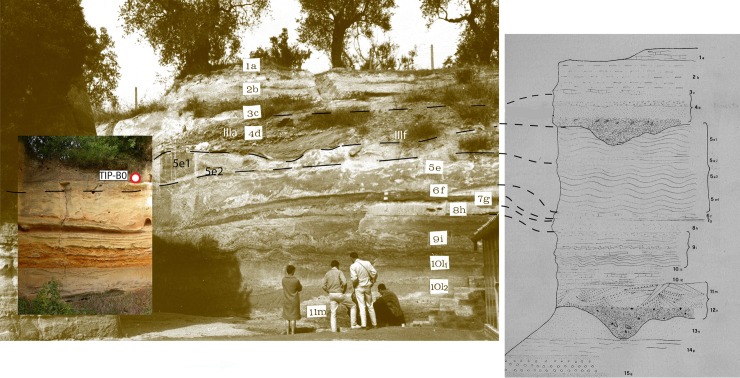
Stratigraphy of the main Torre in Pietra section.Center: the main section of excavations carried out between 1955 and 1964; (left) upper part of the Aurelia Formation with position of dating sample TiP-B0; (right) correlation with layers as drawn by [1]. The center and right panels of the figure are reprinted from [1] with permission by the Italian Institute of Human Paleontology (S4 File).